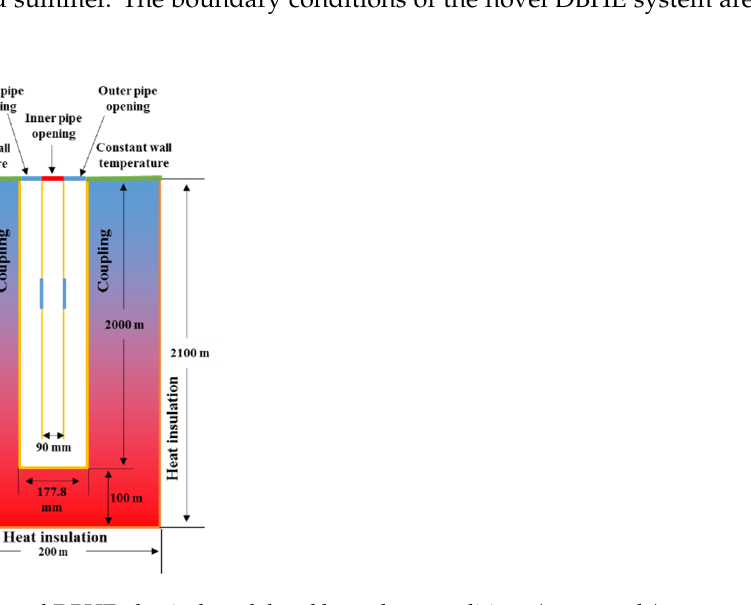
Figure 2. the novel DBHE physical model and boundary conditions (not to scale). Figure 2. The novel DBHE physical model and boundary conditions (not to scale). Table 1. Boundary conditions of the novel DBHE system. Table 1. Boundary conditions of the novel DBHE system.